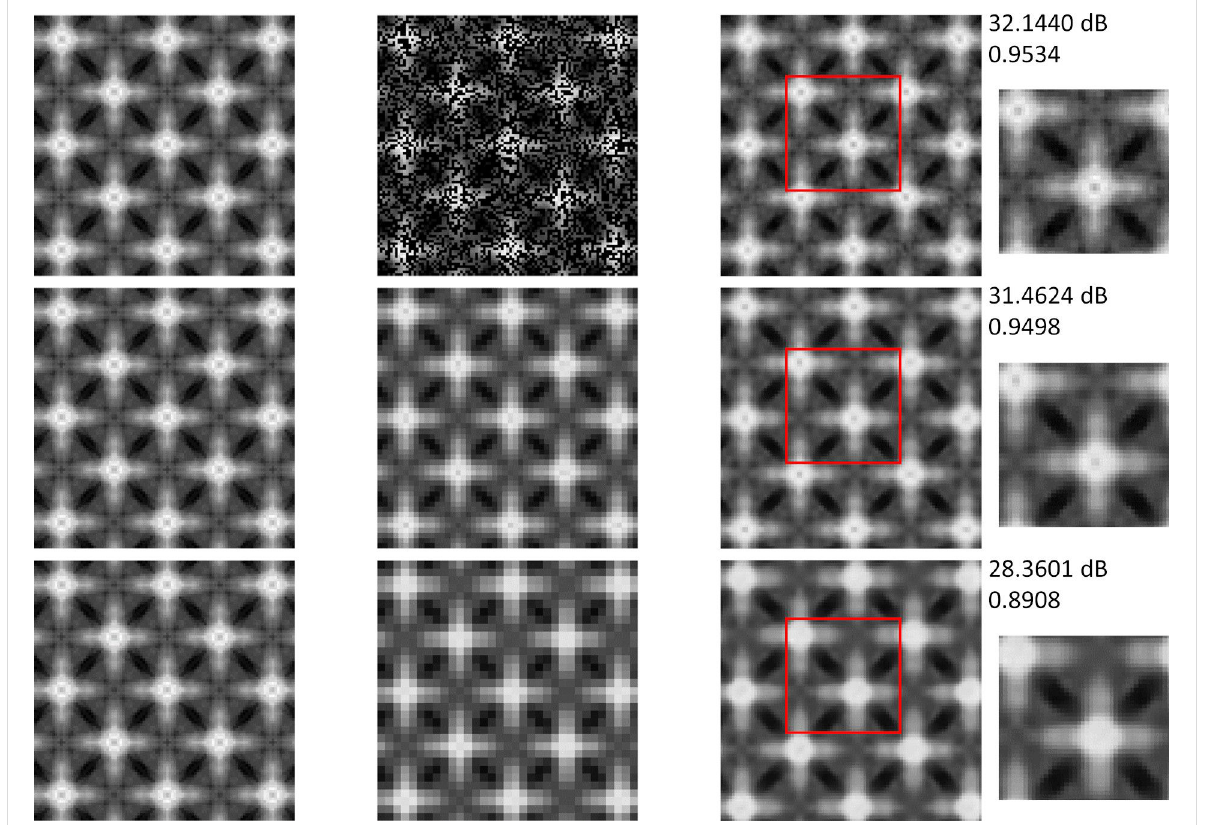
Figure 7: The reconstructed results of Figure 5h with size of 101 × 101. The first line is the result of the BCS algorithm with an undersampling rate of 0.5. The last two lines are the results of the SRCNN algorithm with scale factors of 2× and 3×, respectively. The small images on the right show the details of the reconstructed image in the red